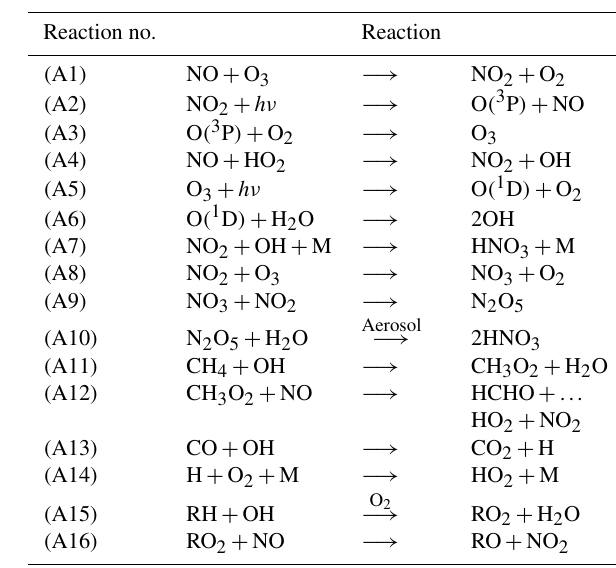
Figure 7. Perturbations in ozone (O 3 ), nitrogen oxides (NO x ) and the nitrogen reservoir species (NO z ) according to simulations using an instant-dilution approach and the plume model. Emissions are re- leased at 08:00LT in a polluted environment. The dotted black line represents all nitrogen species (NO y ), which is a conserved quan- tity. The shaded areas correspond to nighttime.